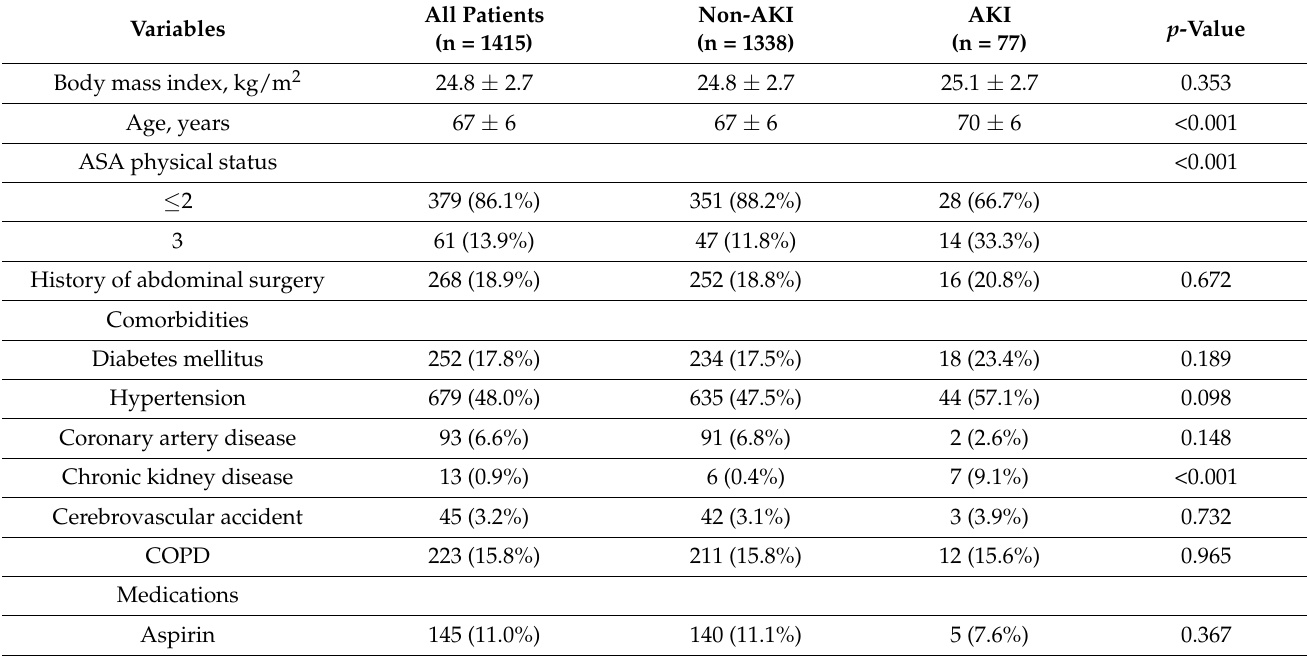
Table 1. Demographics and preoperative laboratory data.